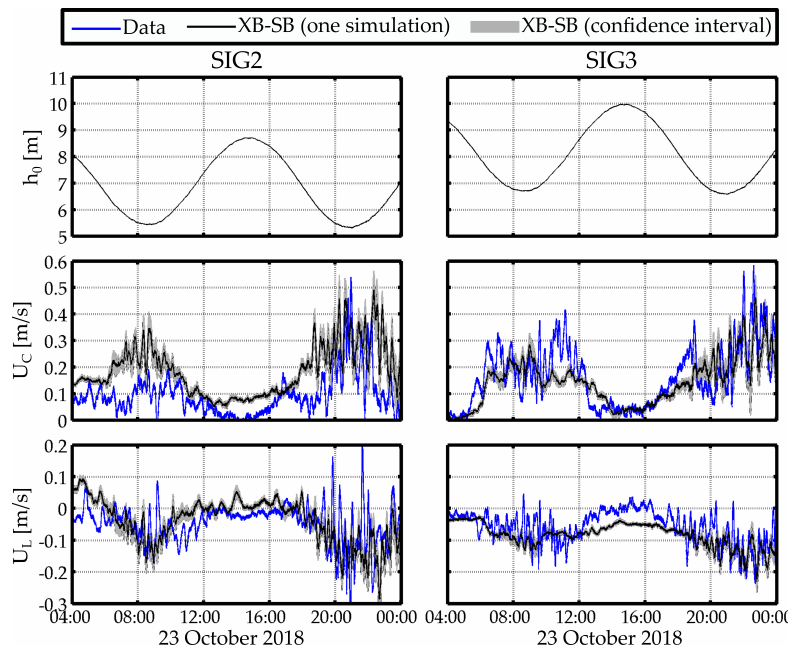
Figure 5. Modelled mean water depth ( h 0 ; top panels). Modelled (black) and measured (blue) 5 min running-averaged cross-shore ( U c ; middle panels) and longshore velocities ( U L ; bottom panels) for event D1 at SIG2 and SIG3 locations. Note that AQ was not measuring at this time. Black line and grey area show the modelled velocities of one simulation and the confidence interval computed from ten simulations (see Section 2.3).